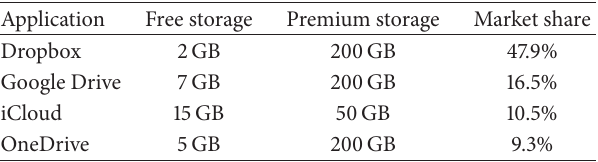
Table 1: Current industry applications of